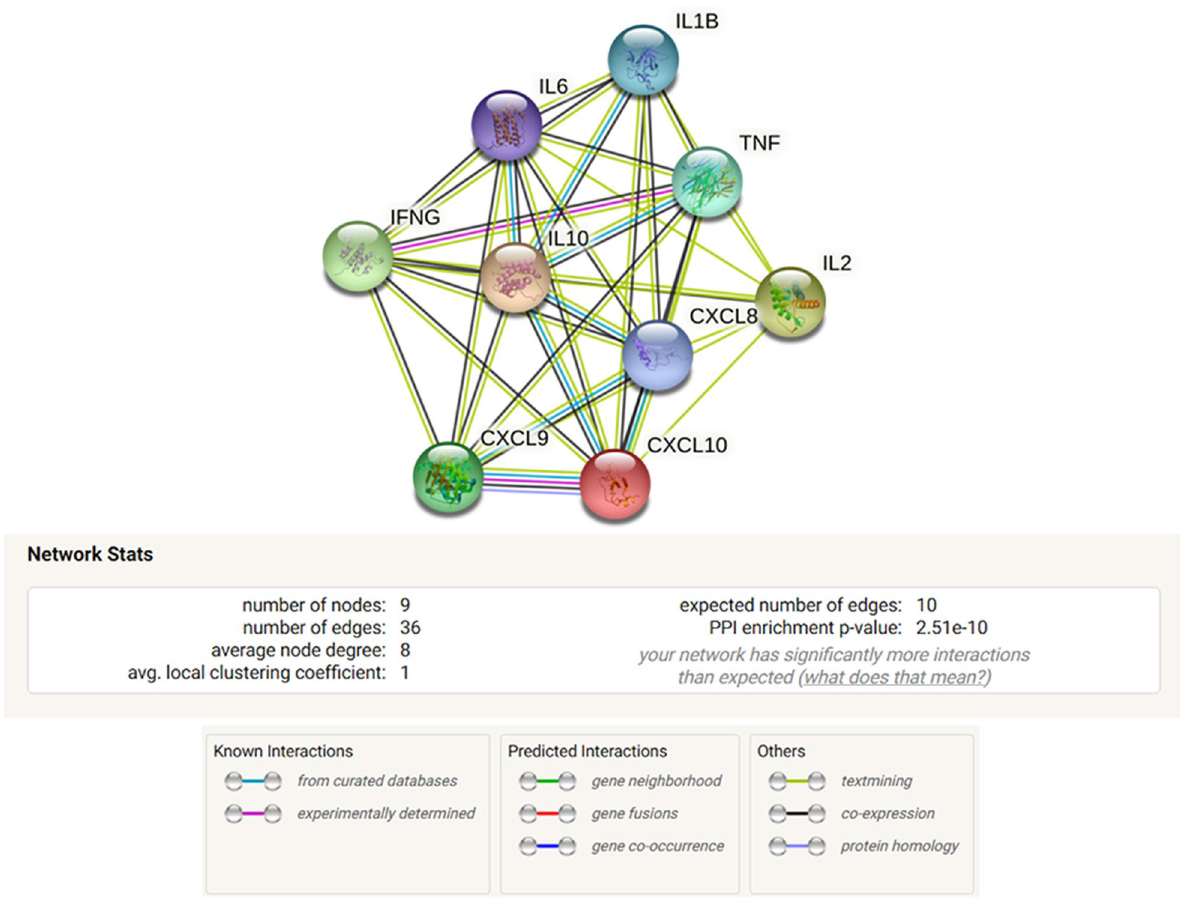
Figure 4. The above figure shows the protein–protein interactions and its network statistics of the significantly altered cytokines in the current study, among chronic SJS patients when compared with normal and the cytokines involved in specific biological processes are detailed in Table 3.